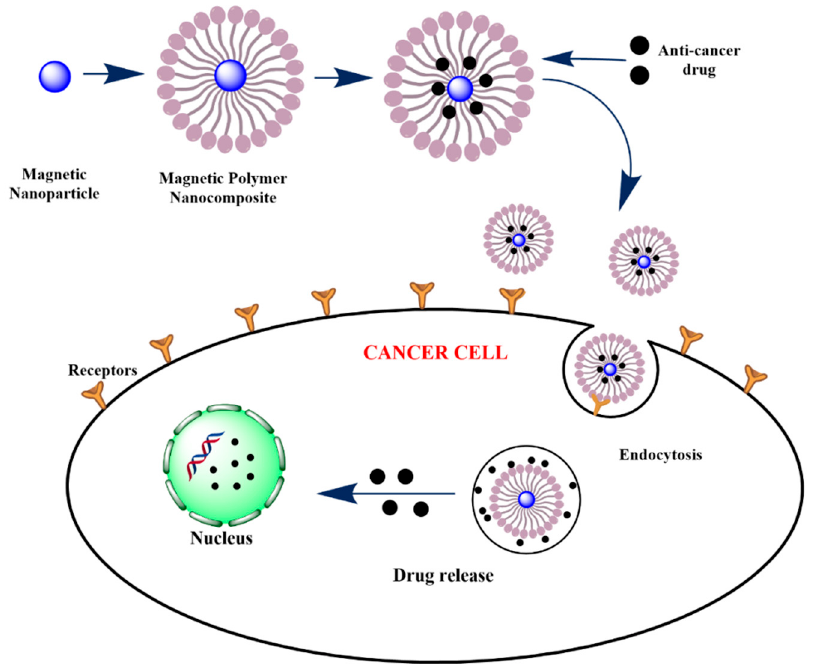
Figure 4. Schematic diagram to describe the synthesis of polymeric MNCs and drug delivery in cancer cells mediated by MNPs. cancer cells mediated by